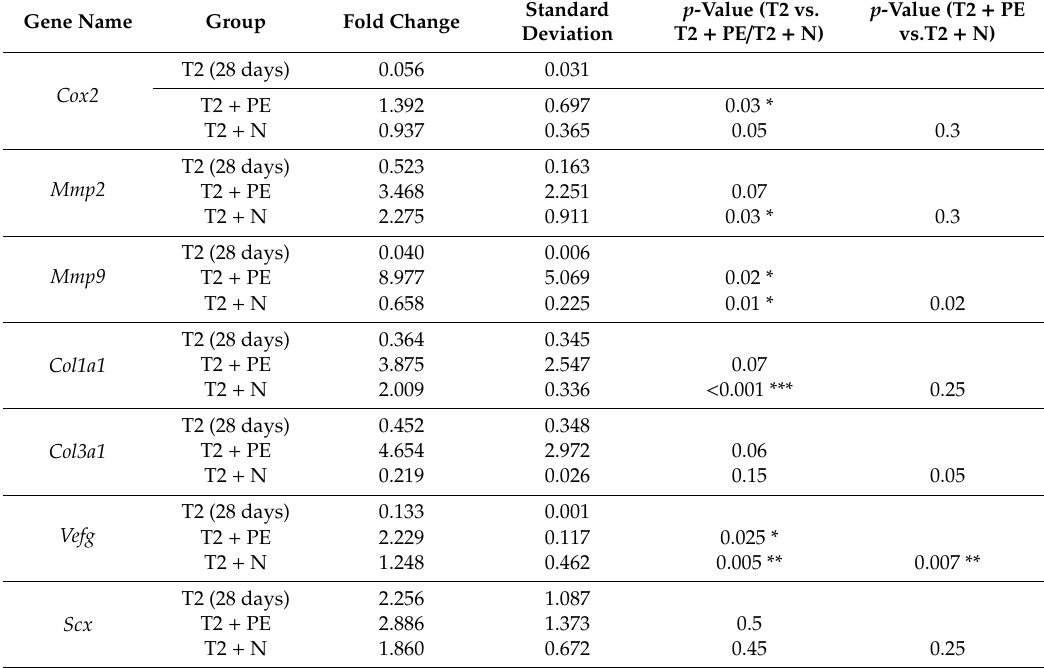
Table 4. Gene Expression Levels in Experimentally induced Tendinopathy Achilles Tendon of Rats (T2) according to intervention (no intervention, percutaneous electrolysis and